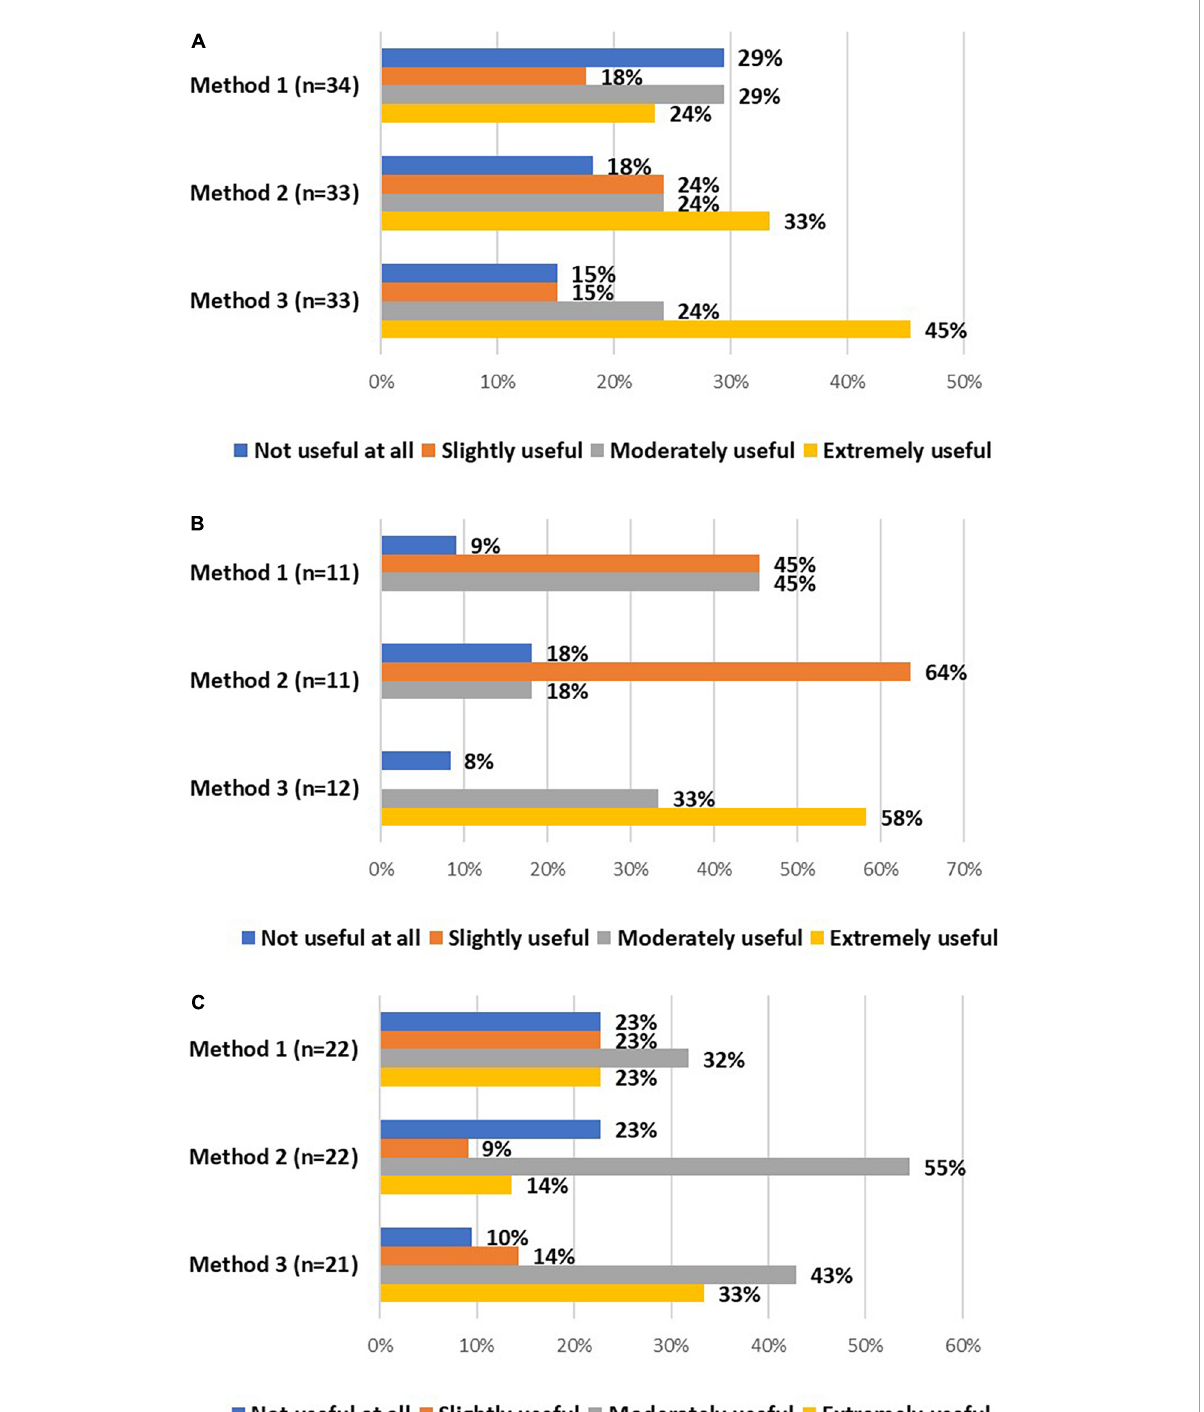
FIGURE4 The views of investigators (A) , DPOs/legal experts (B) , and EC members (C) on the usefulness of method 1 (i.e., if written consent by the research participant is not possible, IC could be given orally by the research participant in the presence of an impartial witness, who is required to sign and date the IC form), method 2 (i.e., the research participant and the person obtaining consent sign and date separate IC forms and an appropriately signed and dated IC should be obtained from the participant as soon as possible), and method 3 (i.e., using validated electronic systems) to obtain IC from COVID-19